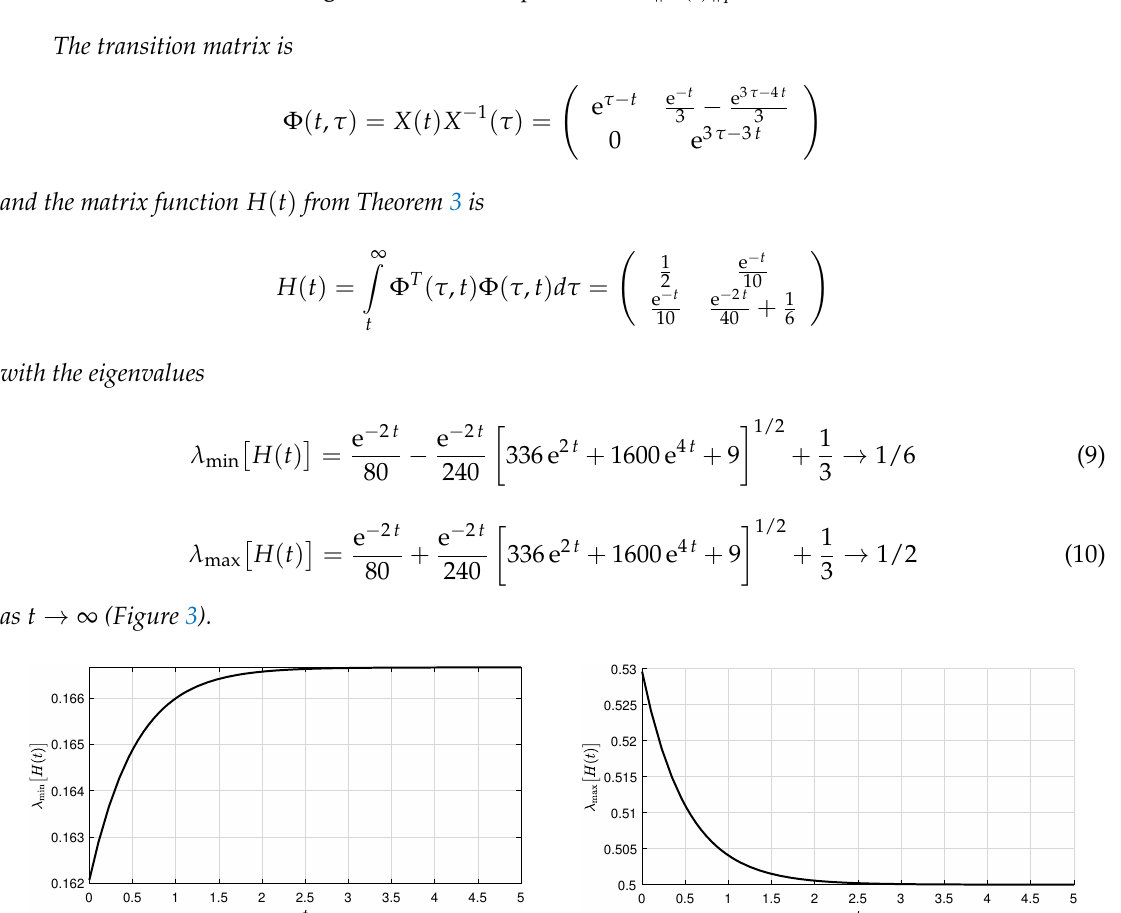
Figure 2. Time development of the (cid:107) A ( t ) (cid:107)